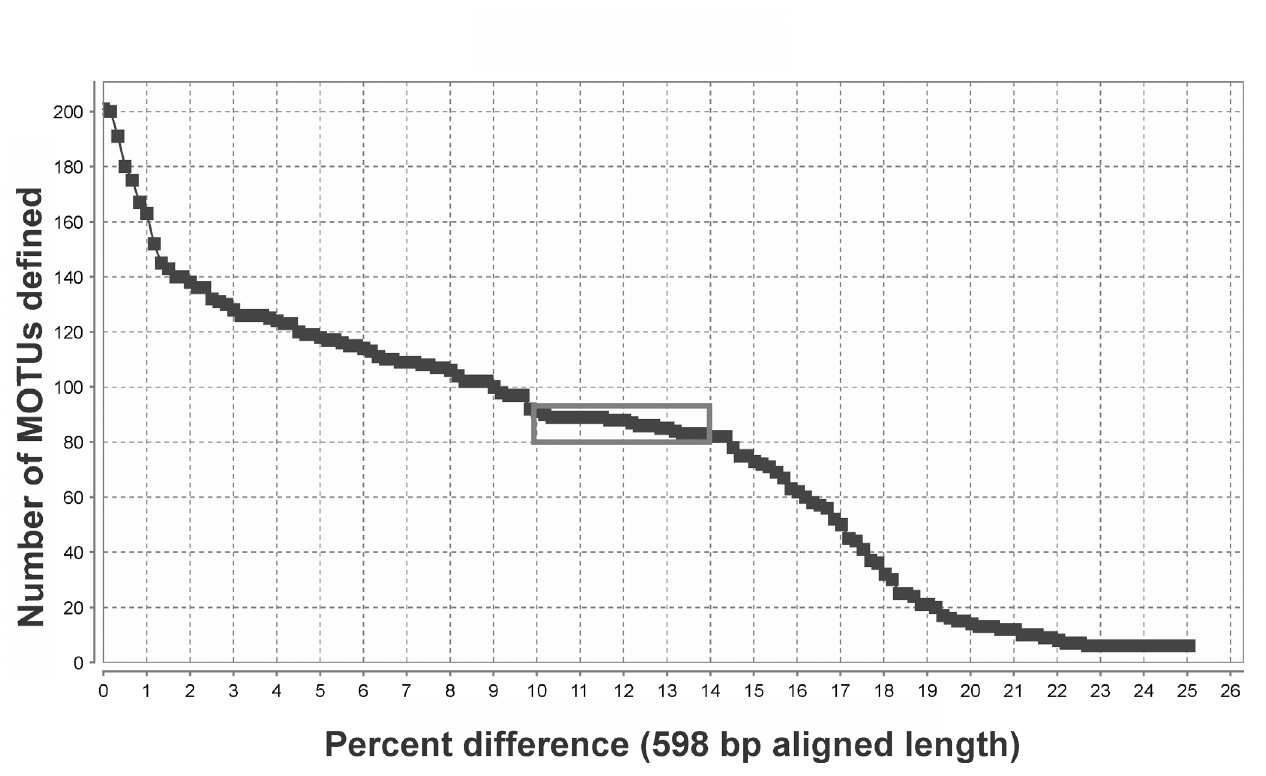
Fig 5. Comparison between numbers of MOTUs and described species. Number of MOTUs inferred from the barcode alignment trimmed to 598 base- pairs using a range of cut-offs (x-axis) expressed as percentage differences. The analyzed data include 78 described species, of which eight are hypothesized to include two or three cryptic species. The box defines a flat section of the graph ranging from 10% sequence difference (defining 91 species) to 14% (82 species).